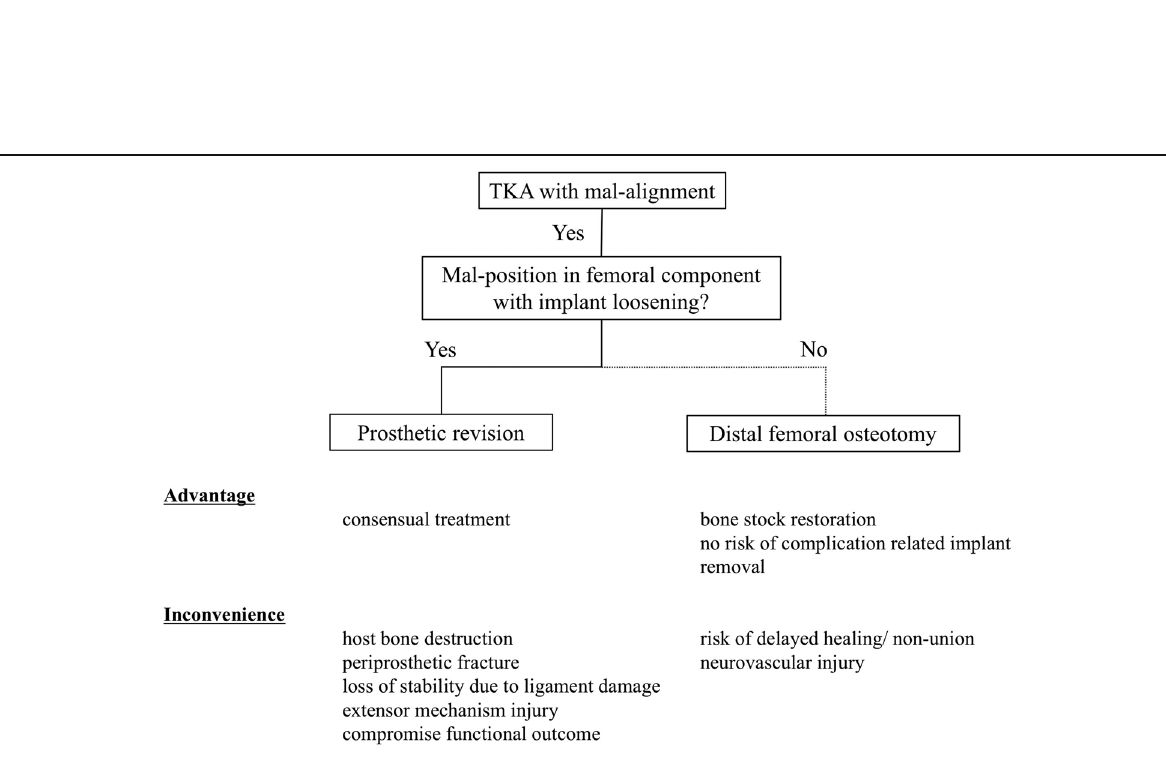
Fig. 7 Surgical strategy, their advantage and inconvenience between osteotomy and prosthetic